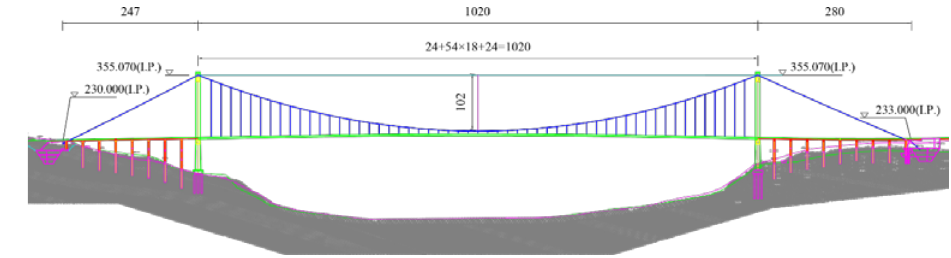
Figure 1. General layout drawing of the bridge (unit: m).